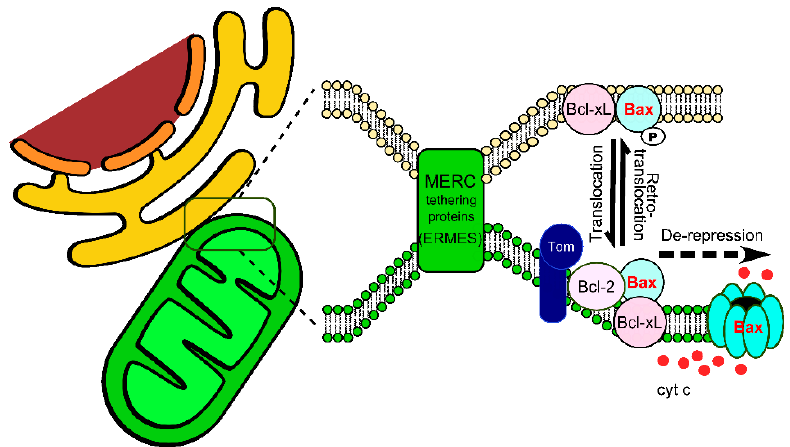
Figure 5. Schematic representation of the involvement of Mitochondria-ER contact sites (MERC) in BAX dynamics. Translocation and retrotranslocation processes are likely favored at MERC. The forced destabilization of the tethering complex ERMES in yeast led to a lower capacity of BAX to localize to the OMM and to promote the release of cytochrome c [24]. Components of the TOM complex Tom20 and Tom22 help the localization and/or the adequate conformation of BCL-2 [25,26] and BAX [27–29], respectively. Derepression by BH3-only proteins or BH3 mimetics allows the release of BAX under its active conformation able to form the pore [15,115].